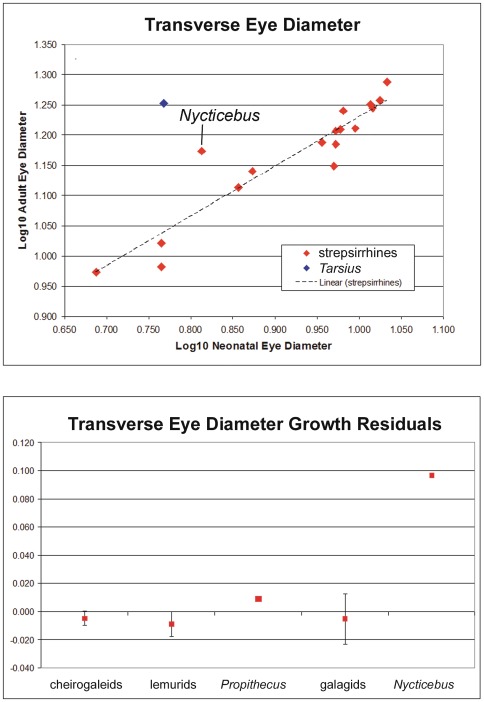
Regression of adult transverse eye diameter against neonatal transverse eye diameter (top).The bottom graph shows growth residuals for transverse eye diameter. The latter are the residuals (which are equivalent to the distance from the regression line), for strepsirrhines only, plotted in taxonomic groups.